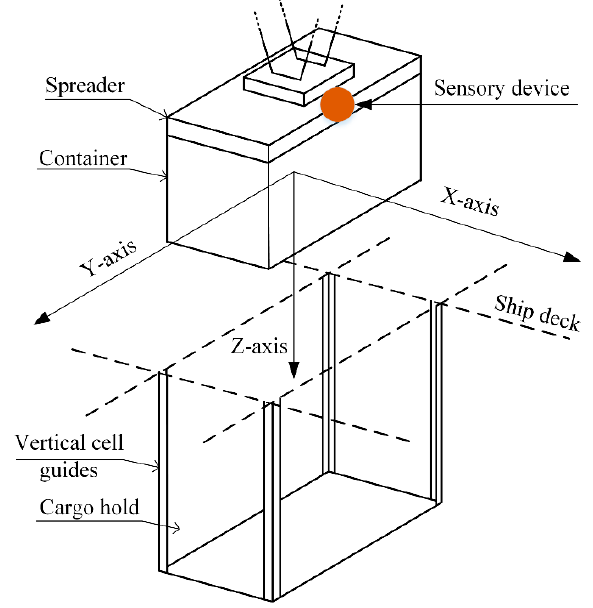
Figure 6. Schematics of container sway detection along with the vertical cell guides. Containers are placed in stacks inside the ship’s hull, one above the other. The Y-axis marks the movement of the container along the ship’s hull. Throughout the entire handling procedure, the main movement of the container occurs along the X-axis. The mounting point of the sensory device is marked by the red dot. The entire process of transporting a single container from the lowest part of the container ship is presented in Figure 7.